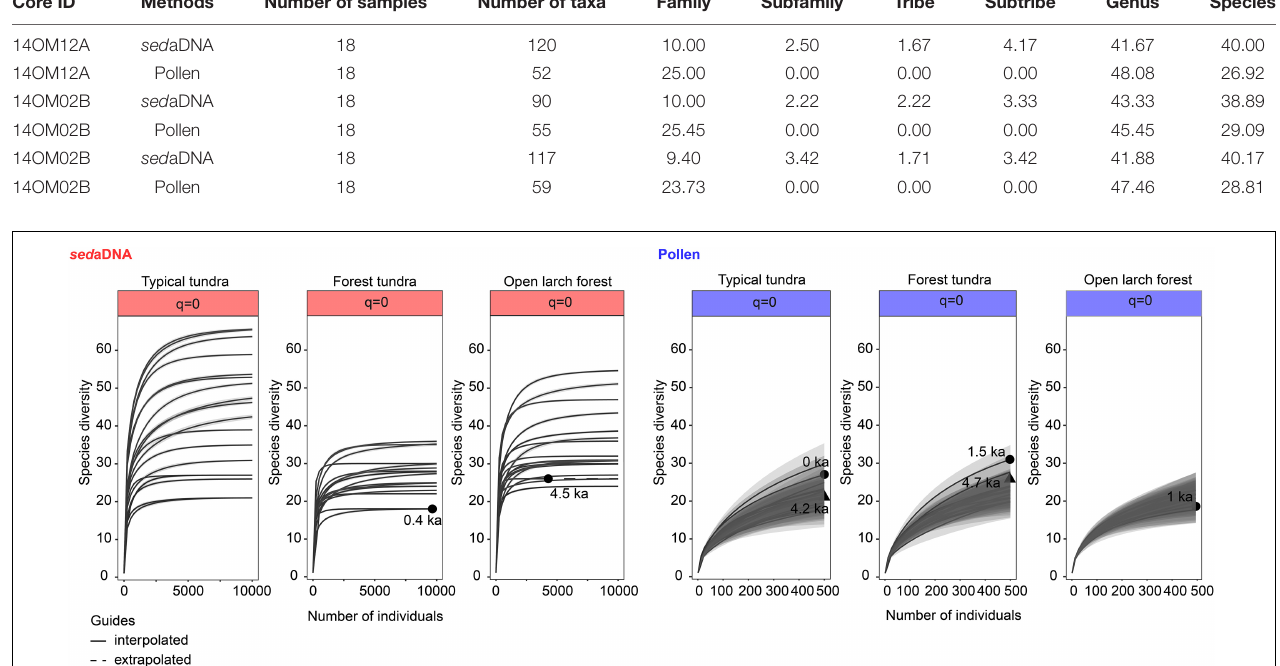
FIGURE 8 | Sample size-based rarefaction/extrapolation sampling curves indicating the estimation of species richness and 95% confidence intervals based on the sed aDNA approach and pollen analysis. The interpolated ages are indicated by the solid lines and the extrapolated age by a dashed line. The shapes indicate the extrapolated